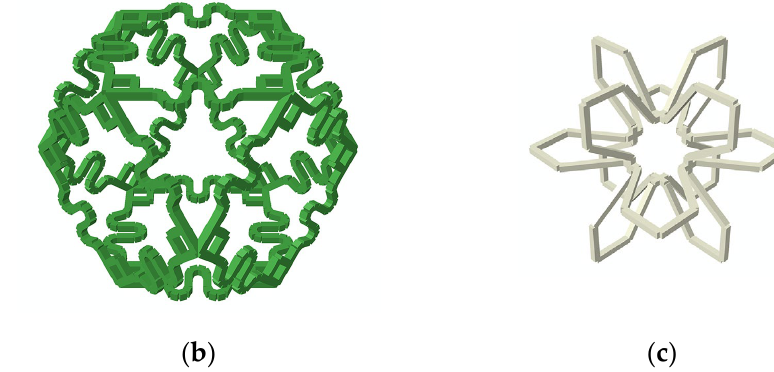
Figure 3. Three types of fundamental cells: ( a ) Rigid cell; ( b ) Compliant cell; and ( c ) Auxetic cell.